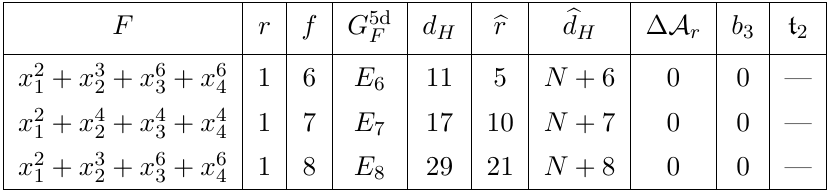
Table 7 . All smooth rank 1 models with smooth divisors and b 3 = 0